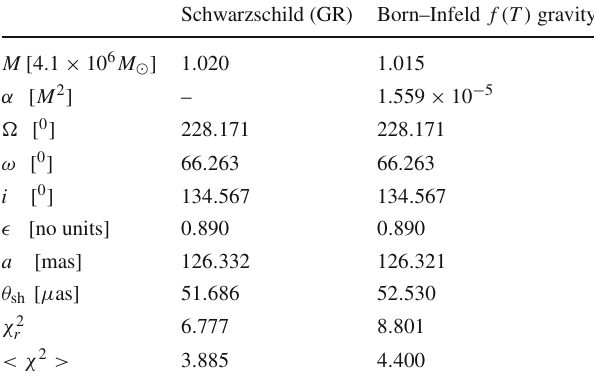
Table 1 In the table we present the best fit parameters obtained within 1 σ confidence Schwarzschild (GR) Born–Infeld f ( T ) gravity M [ 4 . 1 × 10 6 M (cid:13) ] 1 .